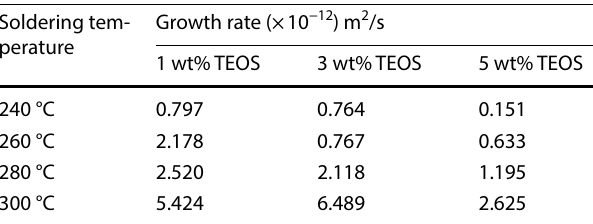
Table 5 Growth rate for samples coated with TEOS and reacted for 24 h and after soldering at various temperatures Soldering tem- perature